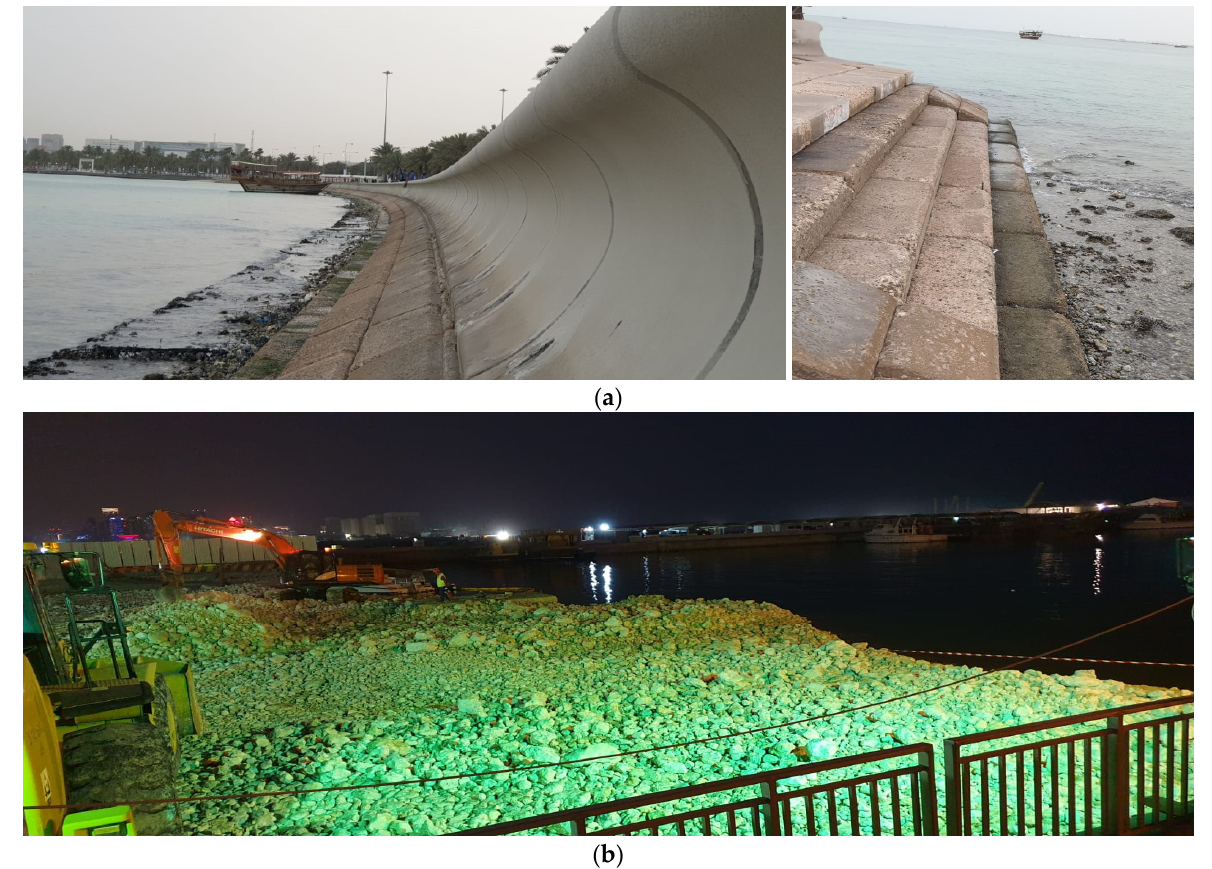
Figure 17. ( a ) Protective shorelines of Al Chorniche (Segment D), ( b ) ongoing land reclamation near Doha Port.